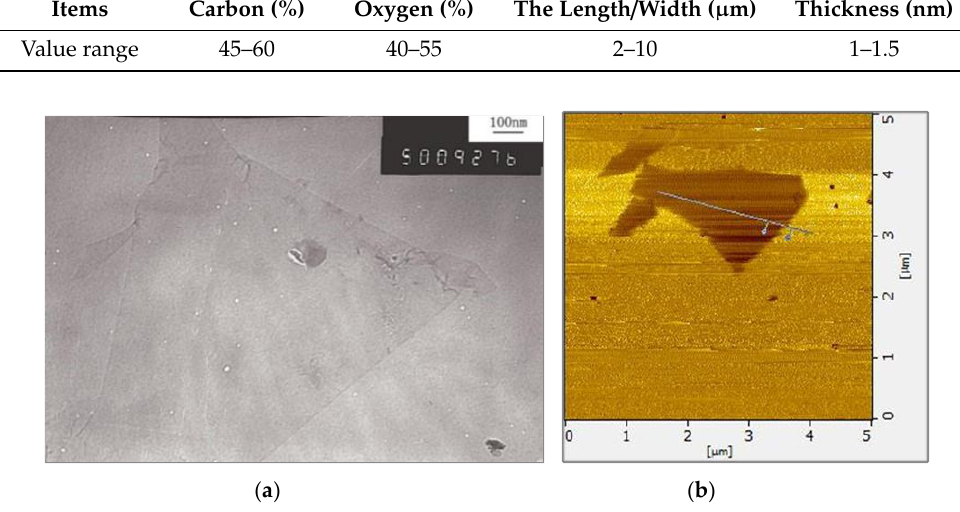
Figure 1. Images of typical GO nanosheet. ( a ) transmission electron microscopy (TEM), ( b ) atomic force microscope (AFM).